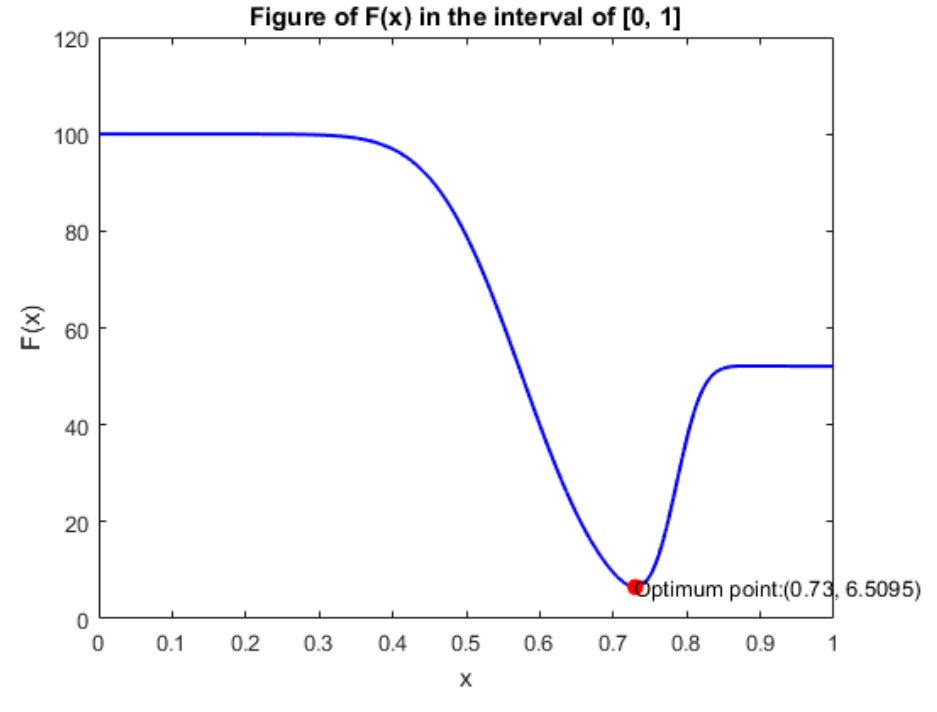
Figure 11. Optimization result of V1.